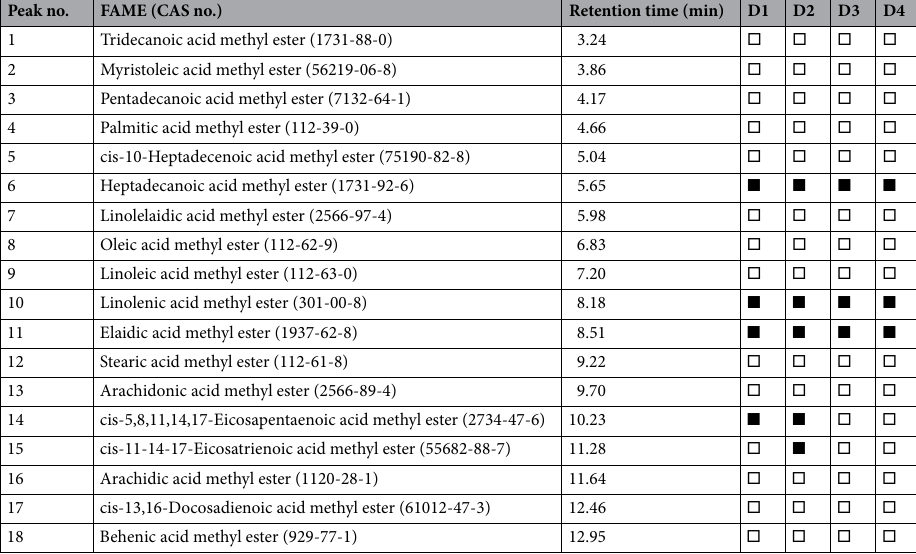
Table 2. List of FAMEs in the standard and diesel sources analyzed in the TIC mode. ■ indicate that the FAME was detected and □ implies not detected in each diesel sample.